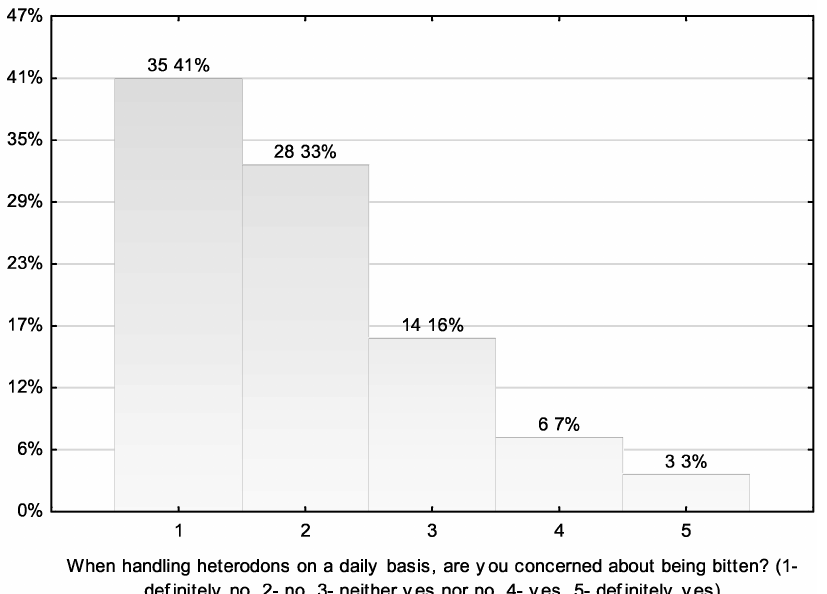
Figure 3. Respondents’ answers to the question about their fear of being bitten by H. nasicus during daily handling ( n ;